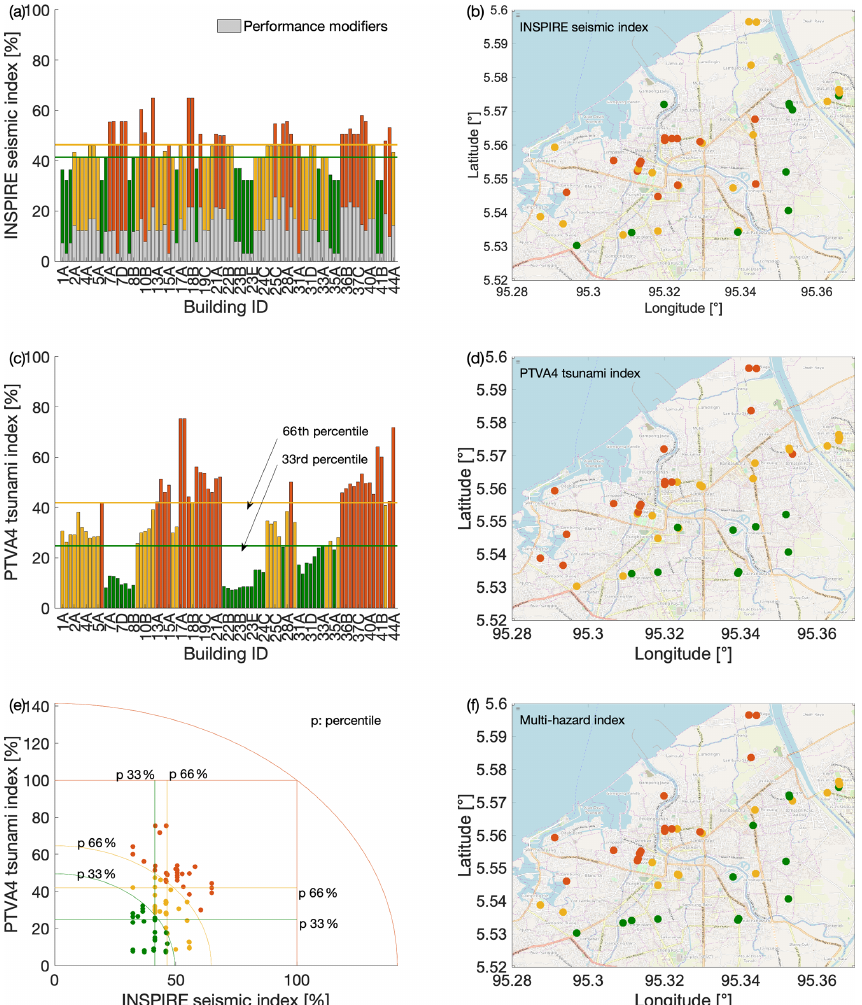
Figure 8. Application to the seismic and tsunami indices to 85 RC school buildings in Banda Aceh, Indonesia. (a, c, e) Seismic, tsunami and multi-hazard indices; (b, d, f) map representation of the same indices. Background maps by © OpenStreetMap contributors 2019. Distributed under a Creative Commons BY-SA